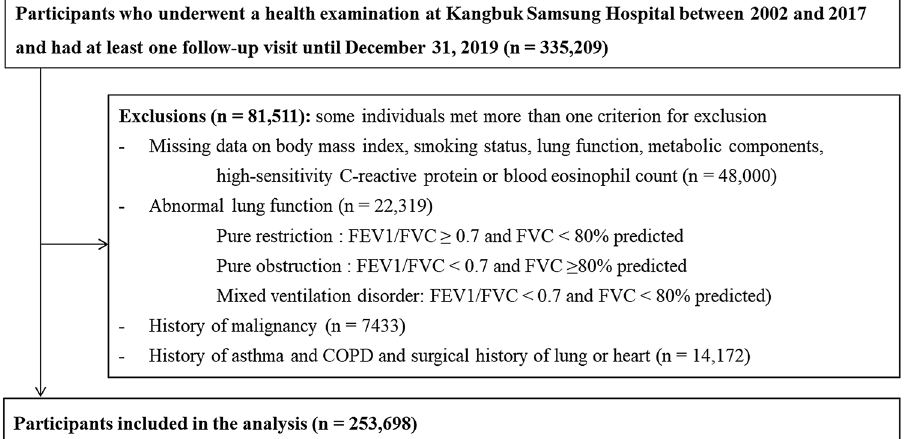
Figure 1. Flow chart for selecting the study population. Out of the 81,511 participants who were excluded, 71,801 met only one exclusion criterion, 9027 met two exclusion criteria, 663 met three exclusion criteria, and 20 participants met four exclusion